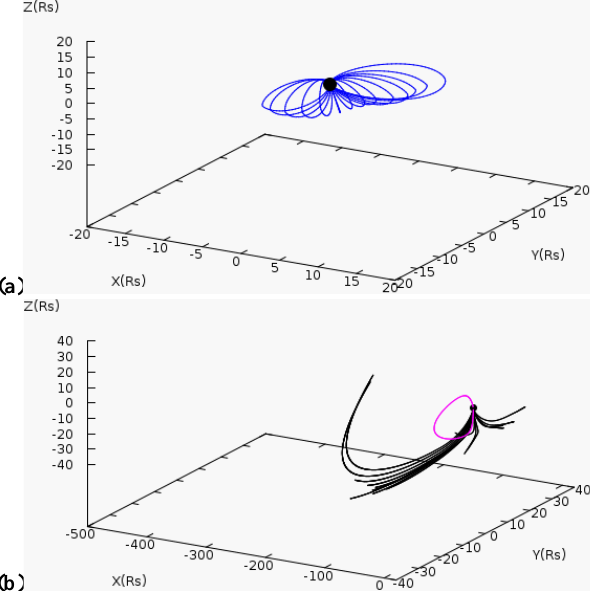
Fig. 9. Field lines mapping to (a) the equatorward and (b) the pole- ward boundary of the dayside UV auroral oval for image A with k s = 0 . 2, corresponding in the southern ionosphere to the positions indicated by the red crosses in Fig. 2. The format is the same as for Fig. 5.